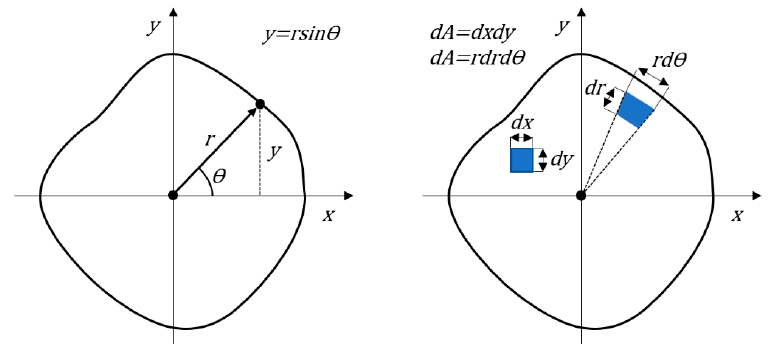
Figure 2. Transition between two different coordinate systems. On the left-hand side: y -axis position noted in cartesian and polar coordinates. On the right-hand side: integral partitions in cartesian and polar coordinates.